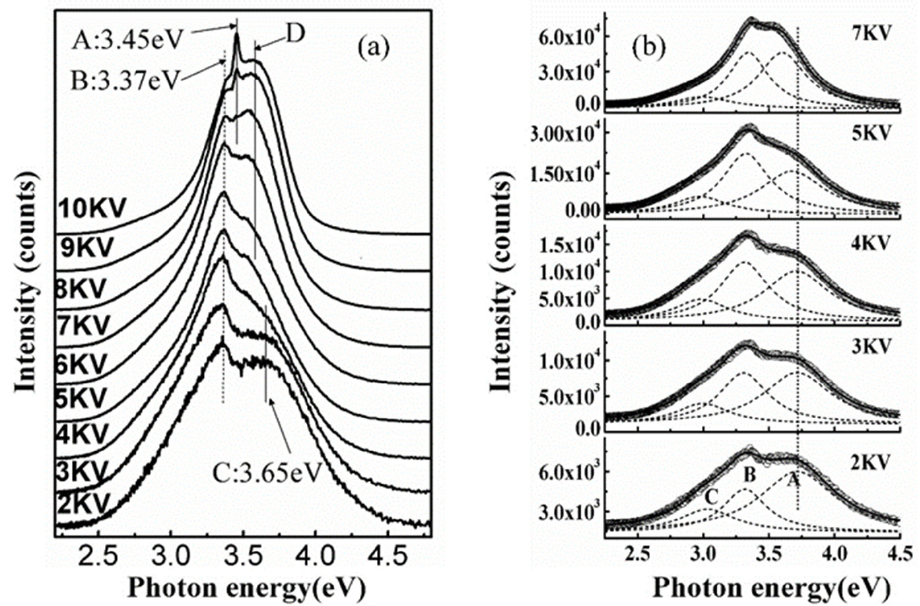
Figure 7. CL characterization of the sample E: ( a ) CL spectra with some different acceleration voltages; ( b ) Gaussian fitting of the CL spectra.